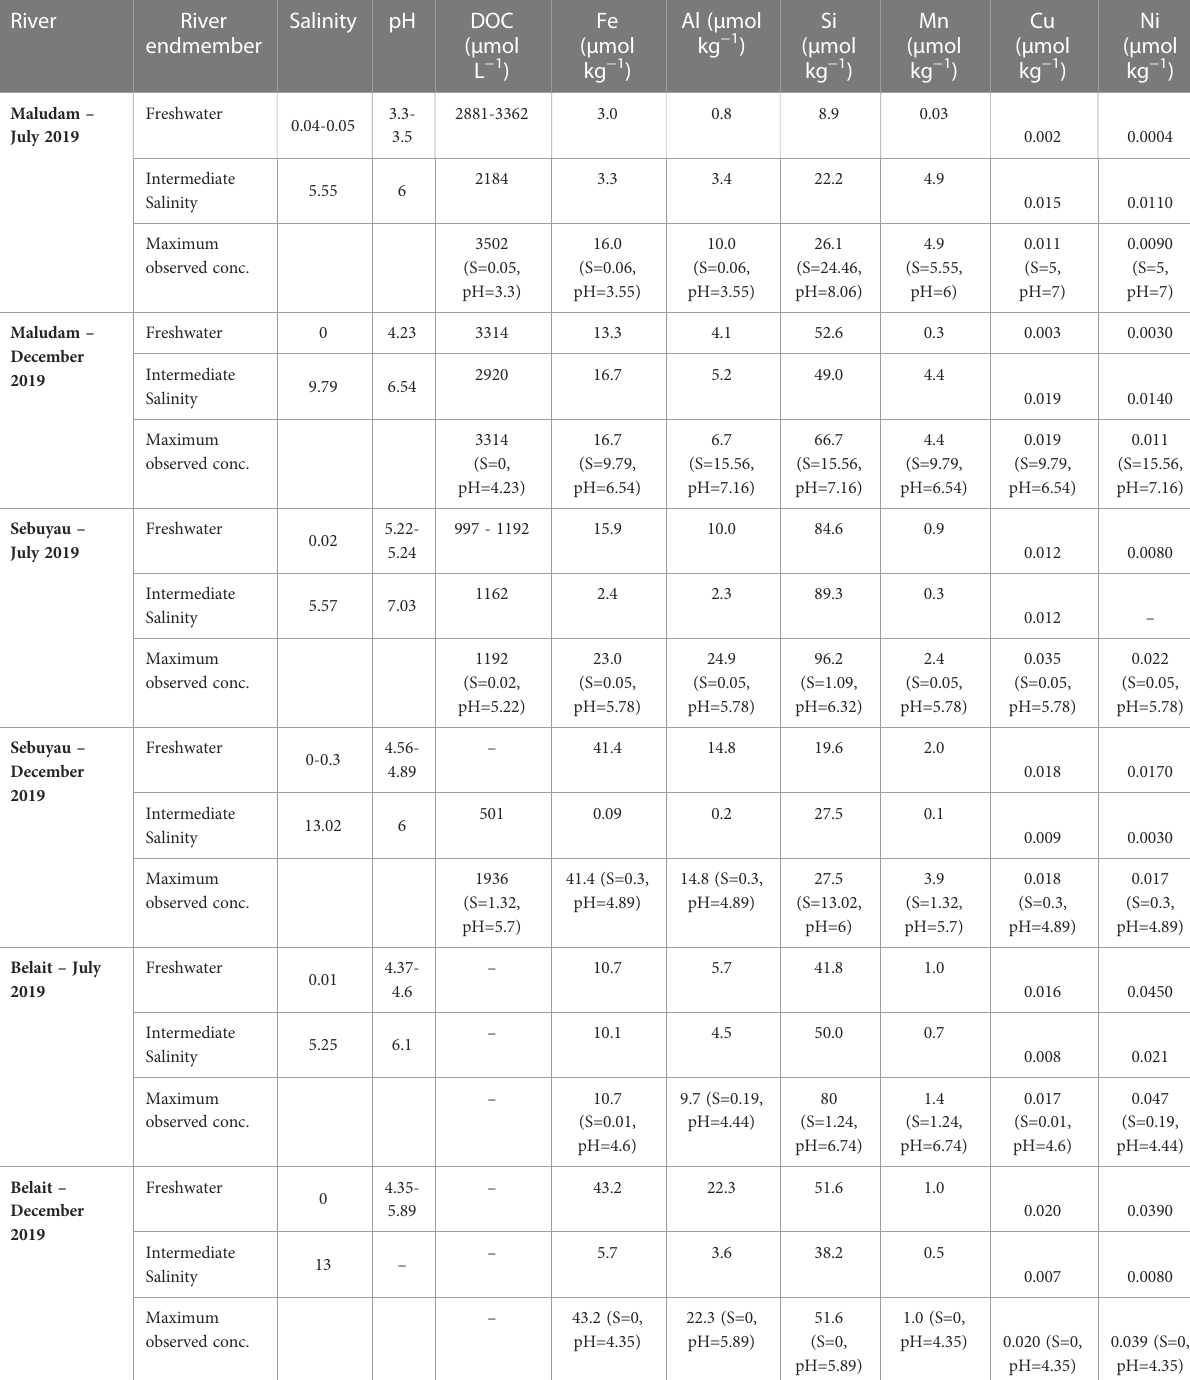
TABLE 4 Range of the master variables. Salinity, pH, and dissolved organic carbon (DOC) in three backwater rivers and estuaries, and the corresponding concentrations of Fe, Al, Si, Mn, Cu and Ni in the fresh water endmember and intermediate salinity. River River